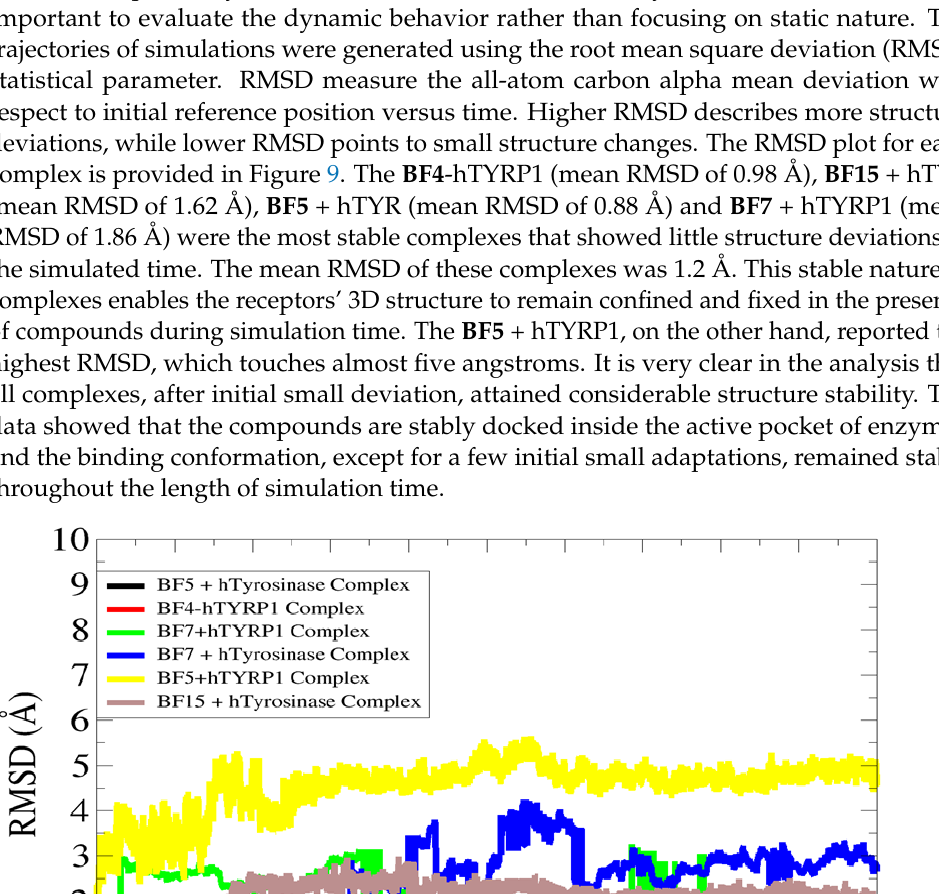
Figure 10. Residue level fluctuation of complexes.